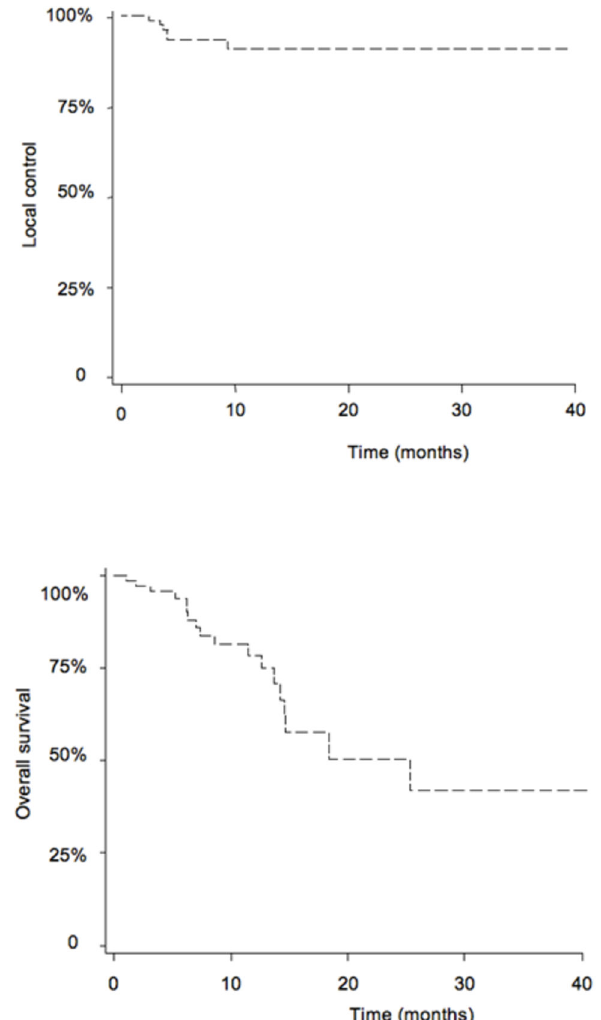
Figure 1. Kaplan Meier curves for local control and overall